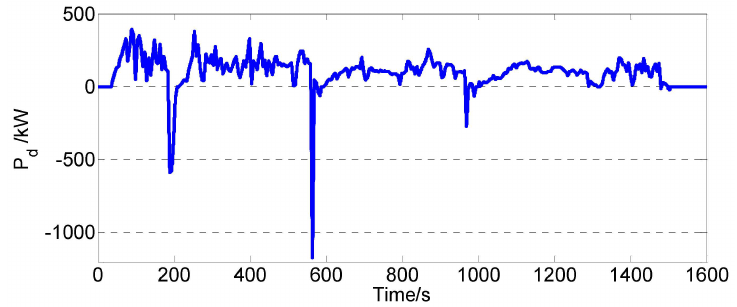
Figure 9. Driving power of EMT vehicles under heavy-duty driving